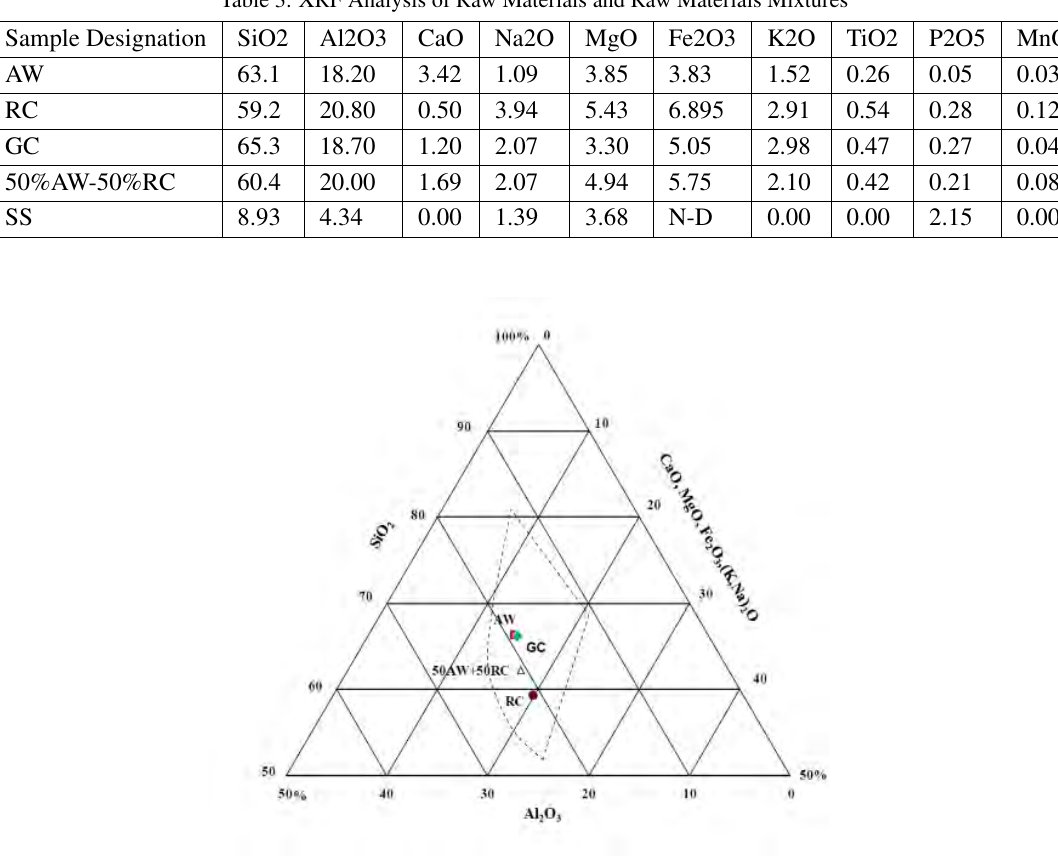
Figure 1. Raw materials and mixtures positioning in Riley’s composition diagram of major oxides